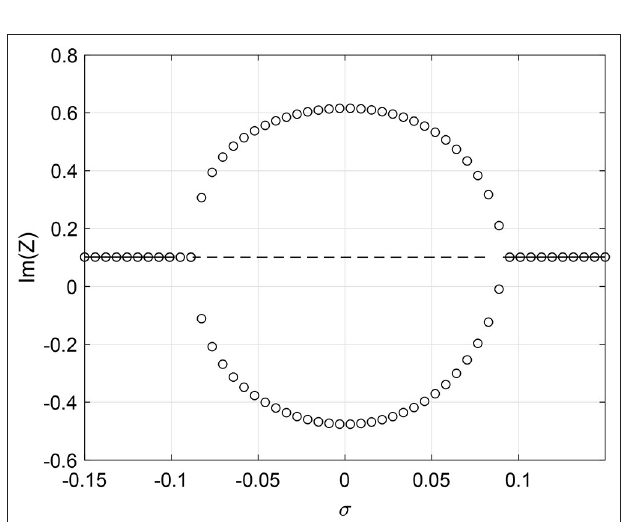
FIGURE 14 | Phase shift dependence β ( k out ) fixed point of (44); dashed line: unstable fixed point. Circles: maximum and minimum over one period of Re( Z ). Other parameters: